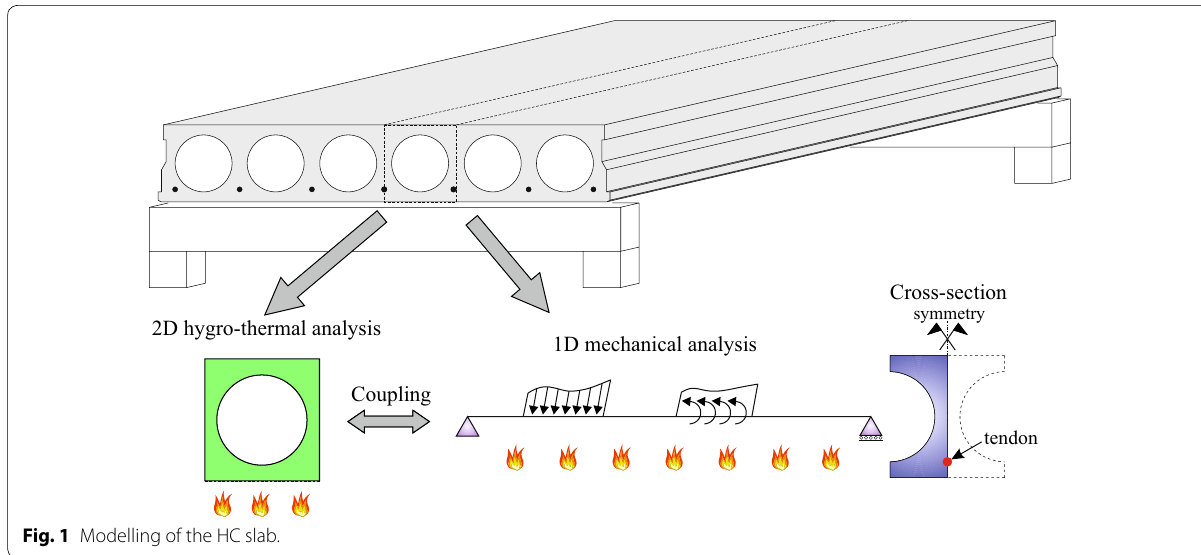
Fig. 1 Modelling of the HC